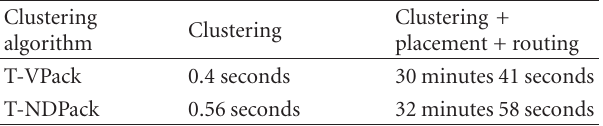
Table 7: Execution time over 20 MCNC benchmarks on pentium iv, core 2 Duo, 2.8GHz with 4 GB RAM. timing measurements are based on running experiments ten times and taking their average.